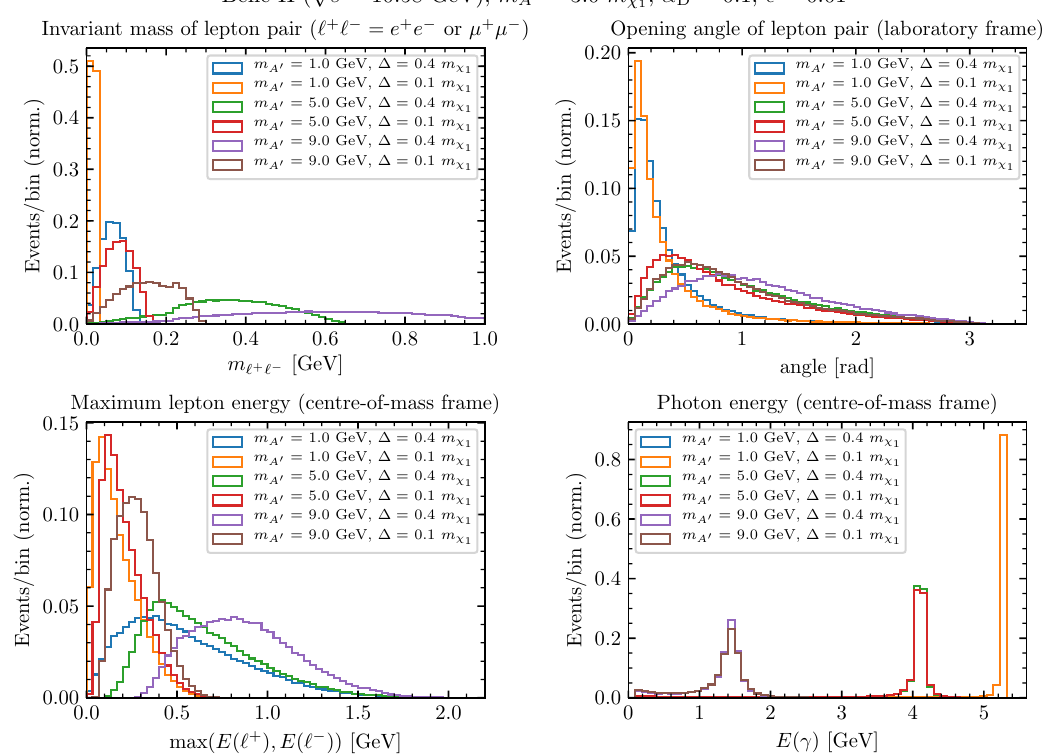
Figure 3 . Histograms of various observables for our signal (top left: invariant mass of the lepton pair, top right: opening angle of the lepton pair, bottom left: maximum lepton energy, bottom right: photon energy). Note that the opening angle is given in the Belle II lab frame, whereas the maximum lepton energy and the photon energy are given in the centre-of-mass frame in this (cid:12)gure and in the text. In the lower right panel, the curves for (cid:1) = 0 : 4 m (cid:31) m A = 1 GeV completely 0